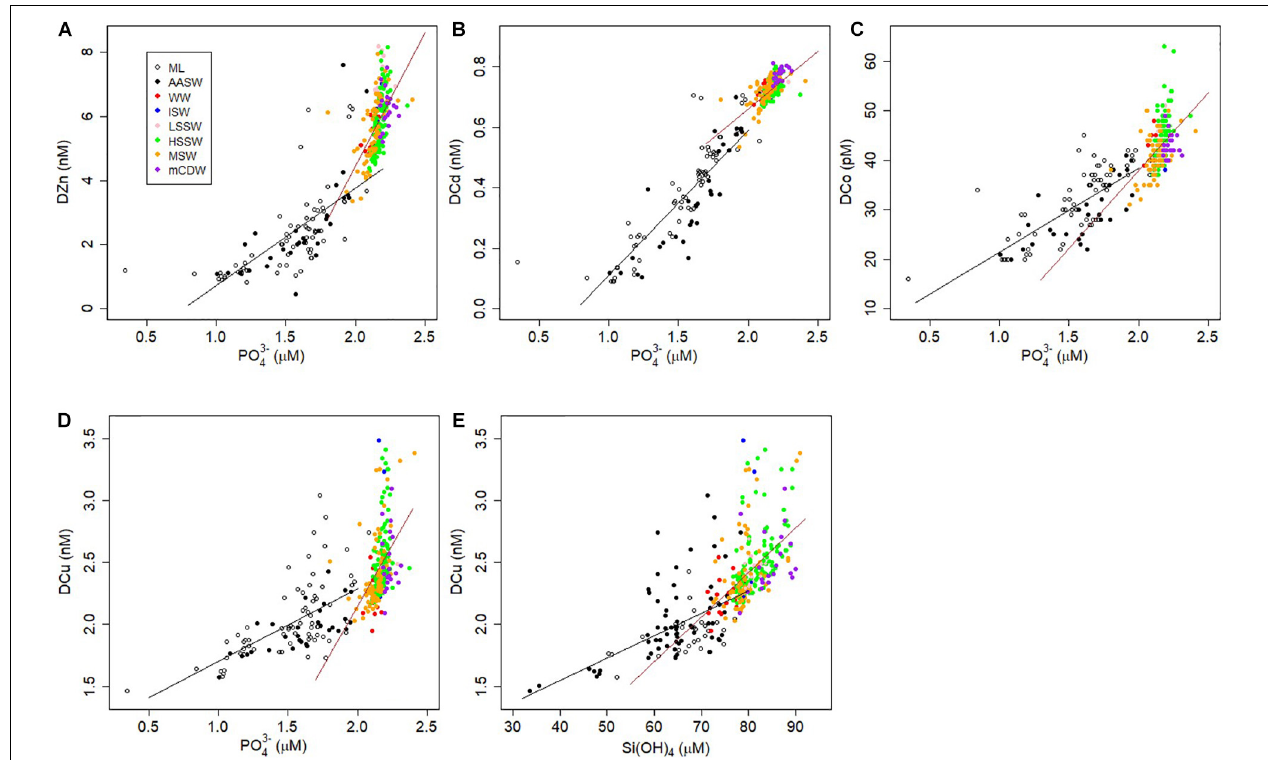
FIGURE 8 | Plots of the distributions of trace metals (nM or pM) vs. PO 43 − (A–D) or Si(OH) 4 (E) ( µ M) of all stations. (A) DZn, (B) DCd, (C) DCo, (D) DCu. Colors indicate water mass, open symbols are samples within the ML, filled symbols in AASW are from below the ML. Lines reflect the linear regressions Supplementary Table S1 ) between the parameters, in black for samples from AASW, in brown for samples outside